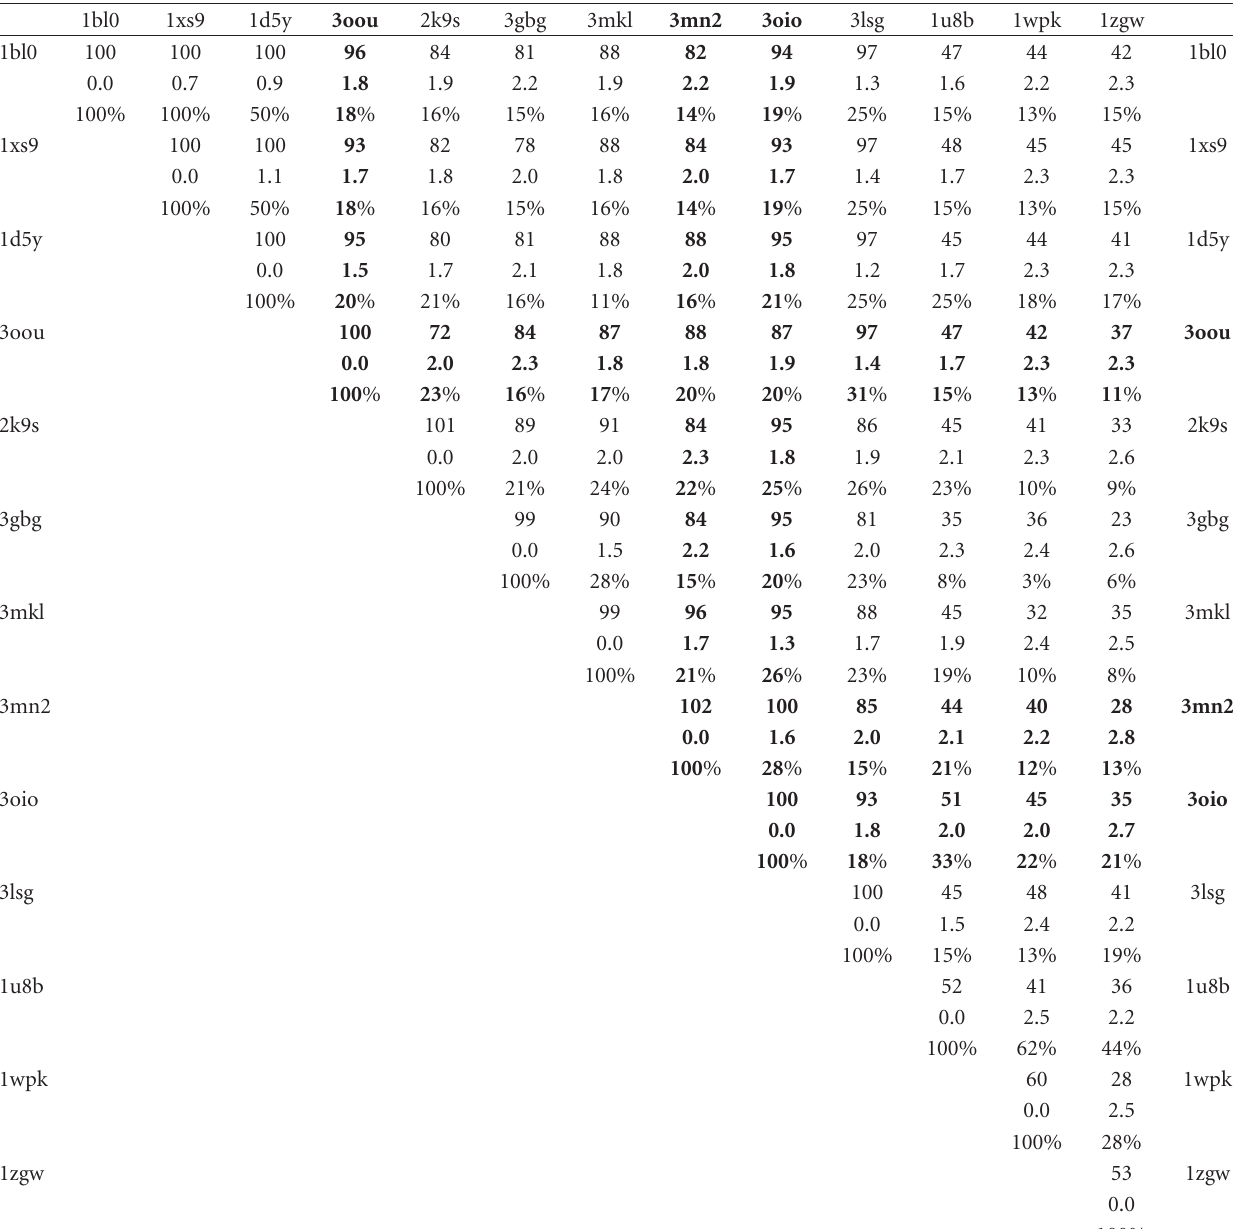
Table 2: Matrix of equivalent residue pairs of available AraC/XylS 3D structures (a) .